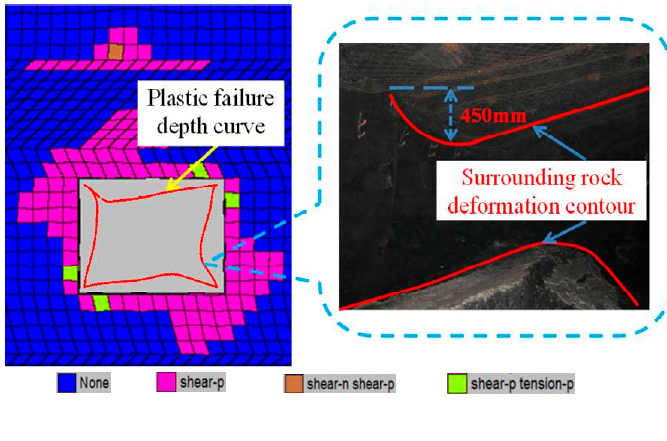
Figure 6. Roof deformation and failure after mining of the panel 81305 No. 2 return airway.